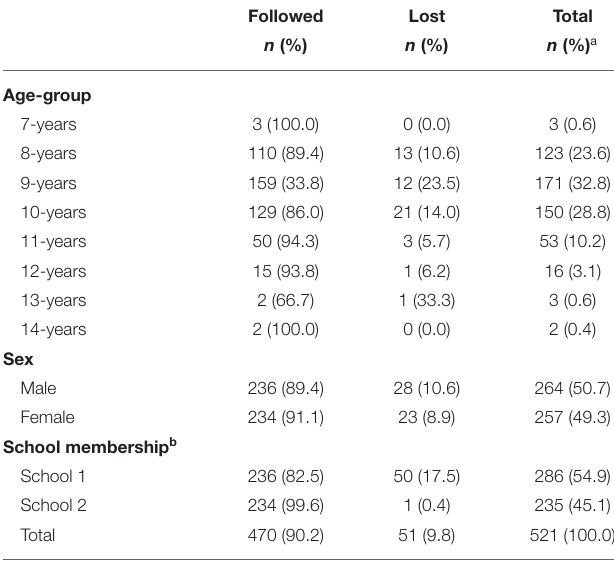
TABLE 3 | Attrition of participants between baseline and 1-year follow-up.